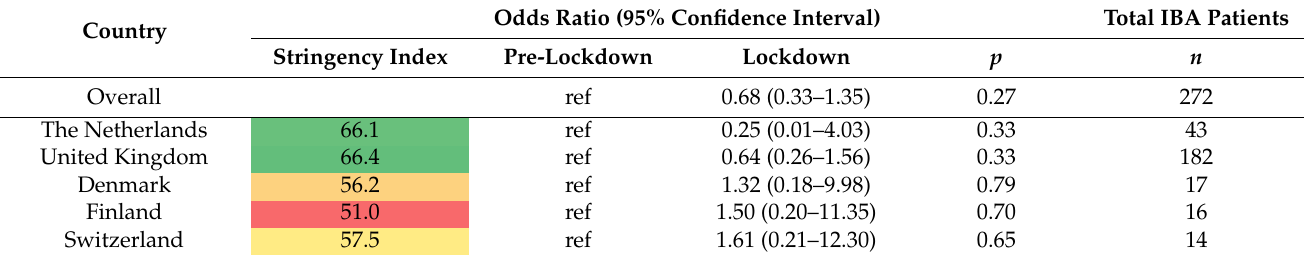
Figure 2. Mean number of IBA patients treated per month in the pre-lockdown period (January 2015 –March 2020) and lockdown period (March 2020–June 2020) in ( A ) countries with national BA data and ( B ) in centres from countries where a part of the national BA data was available. Table 3. Results of logistic binominal regression analysis of IBA incidence prior and during the strict COVID-lockdown per participating country. Odds ratios (OR) are shown which indicates the odds of acquiring IBA during the strict COVID-lockdown, using the odds of acquiring IBA prior to the COVID-lockdown as reference category. Colours represent a range of stringency index where green is the relatively highest and red the relatively